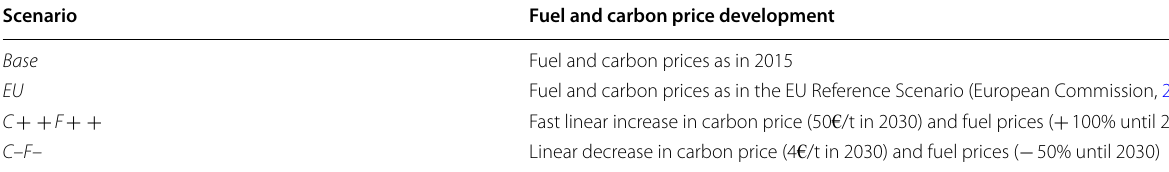
Table 1 Fuel and carbon price scenarios Scenario Fuel and carbon price development Base